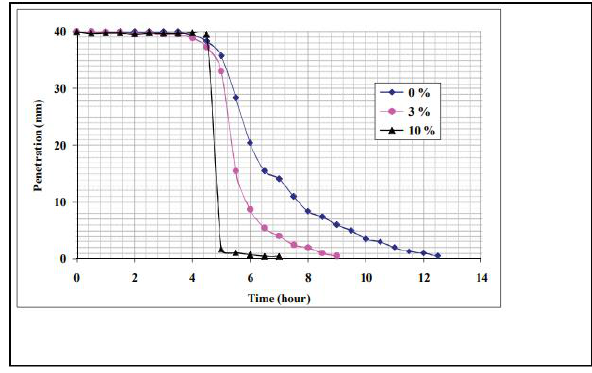
Figure 2: Evolution of setting time